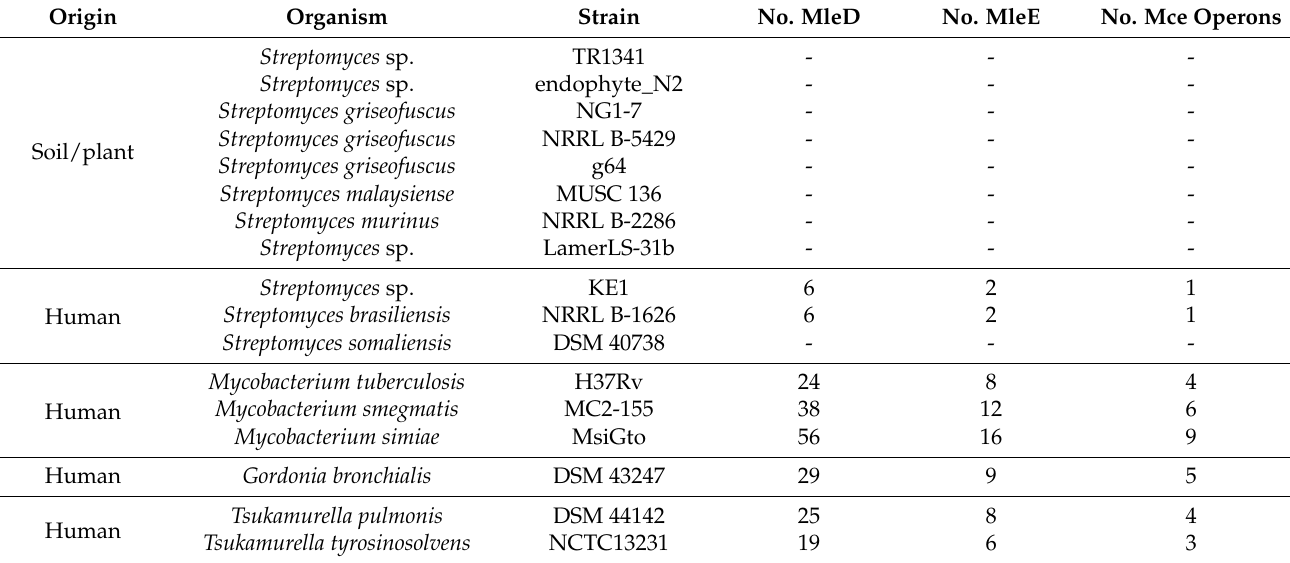
Table 3. Summary of Mammalian Cell Entry (MCE) genes presence in the studied genomes. MleD (Pfam PF02470.20): conserved domain of the two ABC-transporter integral membrane proteins, yrbEA; MleE (Pfam PF02405.16): conserved domain of the six hypothetical proteins,